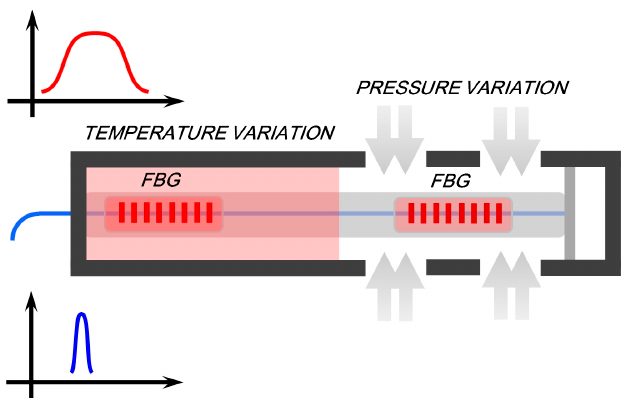
Figure 10. Schematic diagram of FBG sensor for simultaneous temperature and pressure measurements simultaneously.